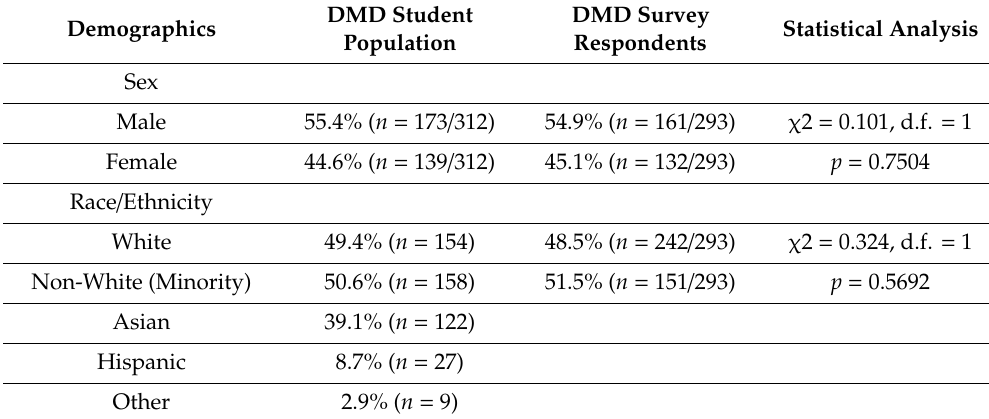
Table 1. DMD student population